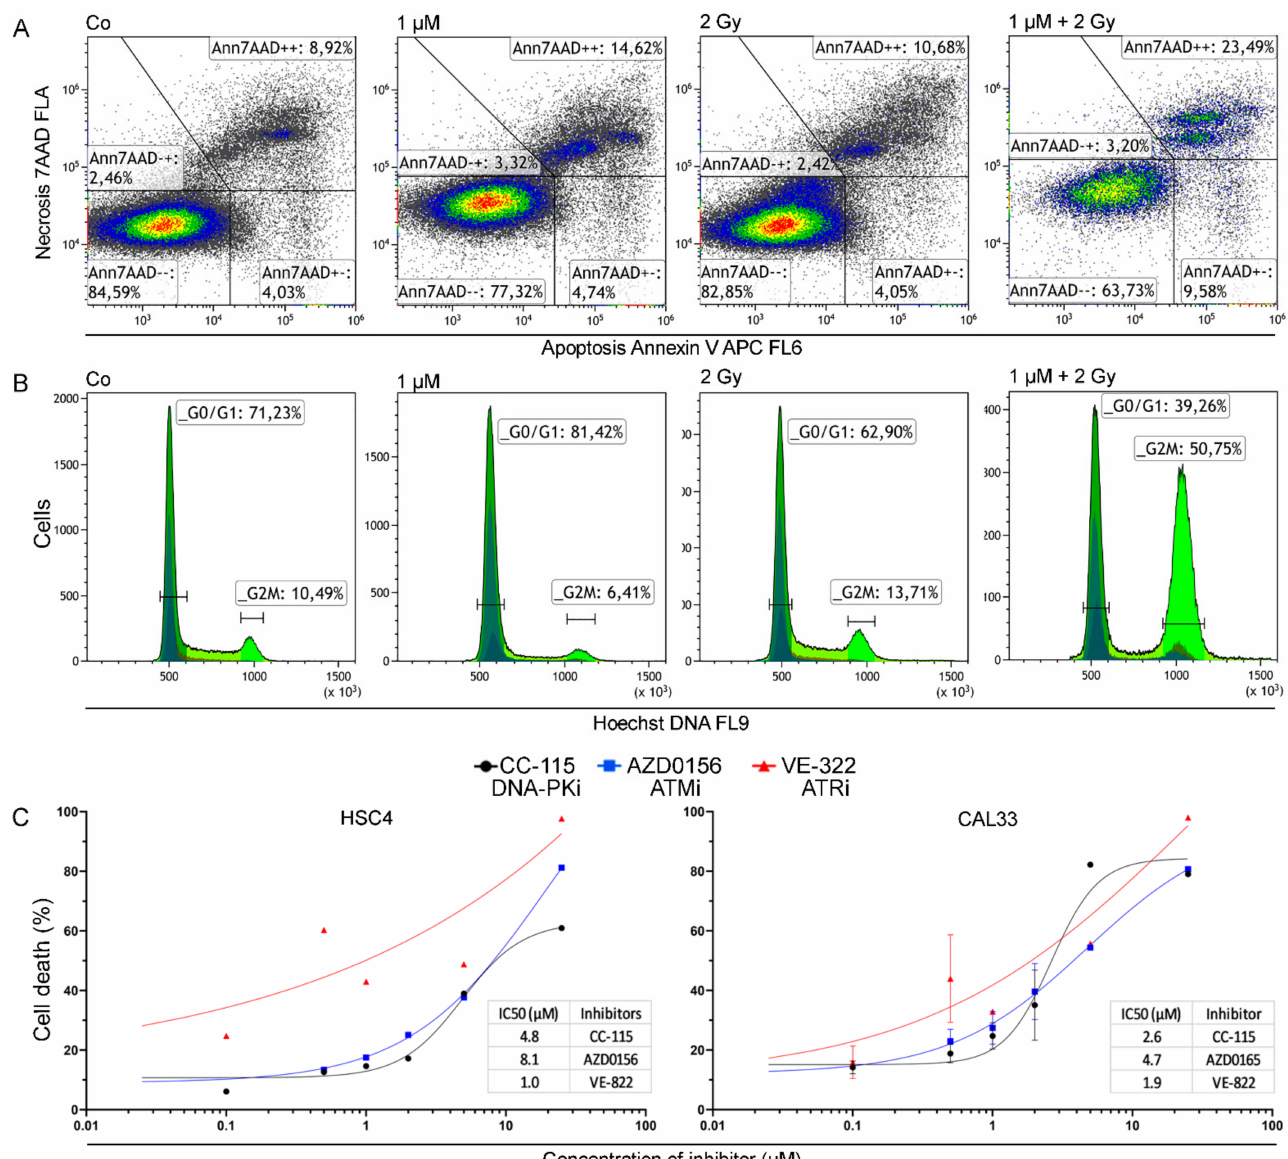
Figure 1. Gating strategies for cell death and cell cycle data and dose escalation studies. ( A ) Dot plot of CAL33 cells untreated, treated with AZD0156, irradiated with 2 Gy, and combined IR and KI treatment to demonstrate the gating strategy of cell death data acquired from flow cytometry analysis. ( B ) Exemplary histograms depicting flow cytometry analysis of cell cycle with focus on G0/G1 and G2/M phases. Histograms show CAL33 cells untreated, treated with AZD0156, irradiated with 2 Gy, and combined IR and KI treatment. ( C ) Dose escalation study for the induction of apoptosis or necrosis (cell death) by the inhibitors CC 115, AZD0156, and VE 822 conducted on HSC4 and CAL33 cells. Each value represents mean ± SD ( n =